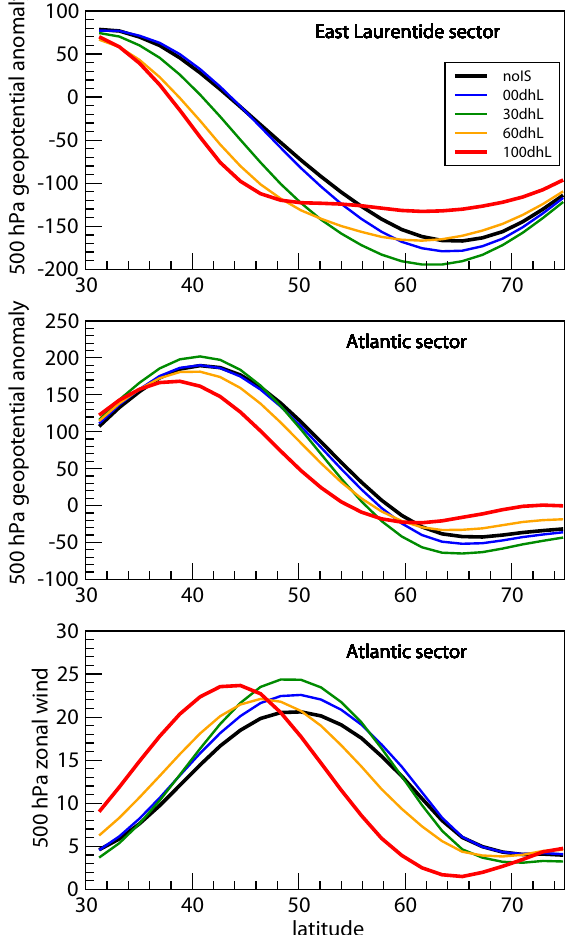
Figure 11. Meridional cross sections of the 500hPa geopotential height anomaly from zonal means over the East Laurentide (90– 60 ◦ W, top panel) and the Atlantic sectors (50–10 ◦ W, middle) in meters, and of the 500hPa zonal wind (in ms − 1 ) for the Atlantic